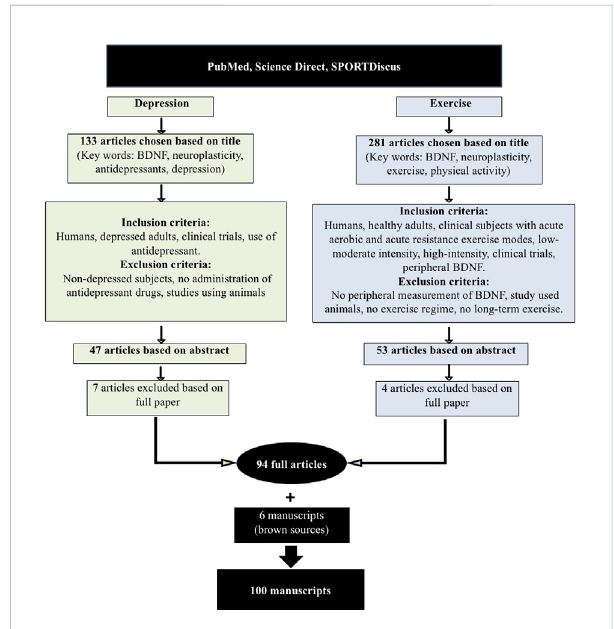
PRISMA fl ow diagram for search and selection